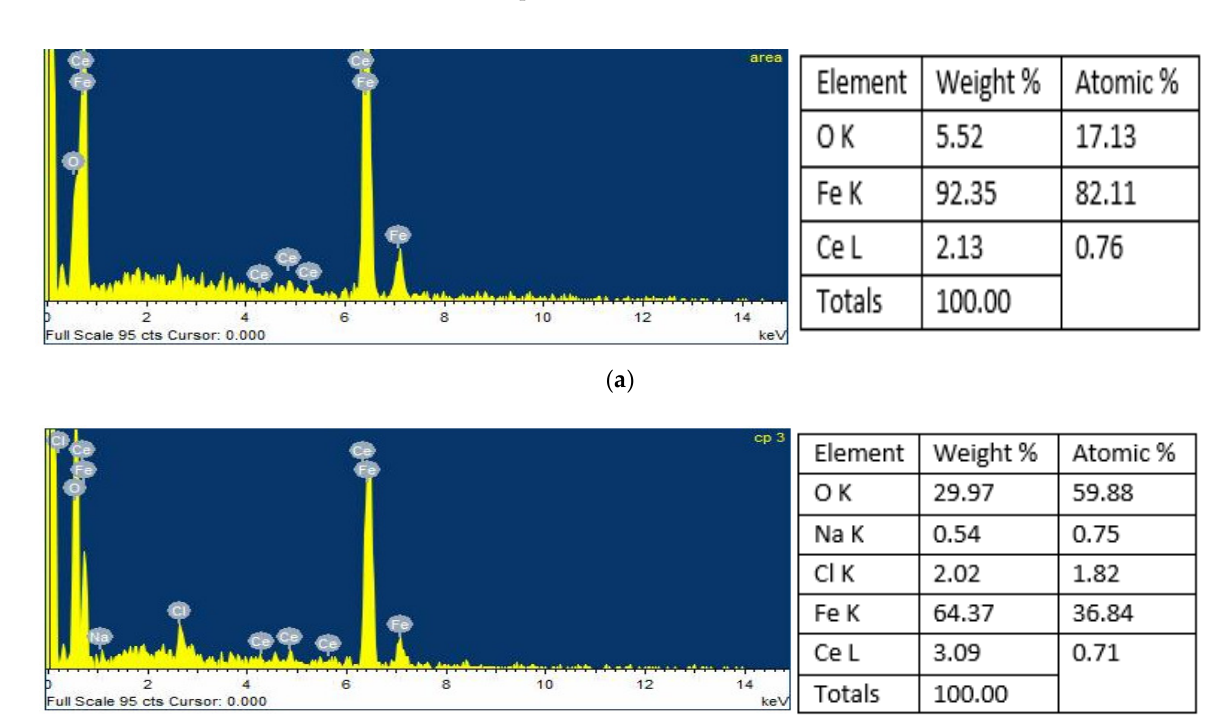
Figure 10. SEM micrographs of 304 SS sample surfaces inhibited with Ce ( hfac ) ( d – f ) obtained after exposure to 3.5% NaCl solutions at 20 °C, 40 °C, and 60 °C.